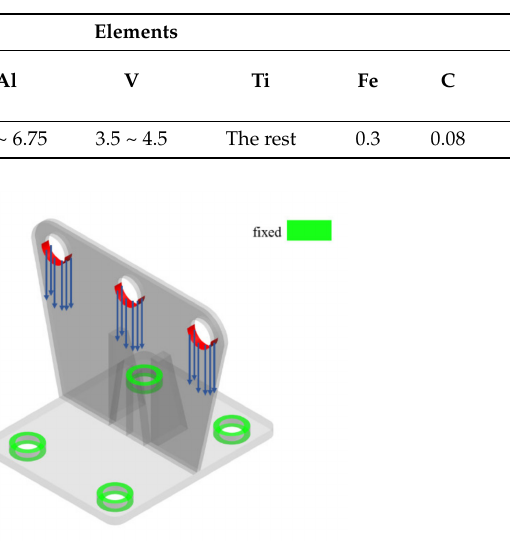
Figure 3. Boundary condition and load condition setting.